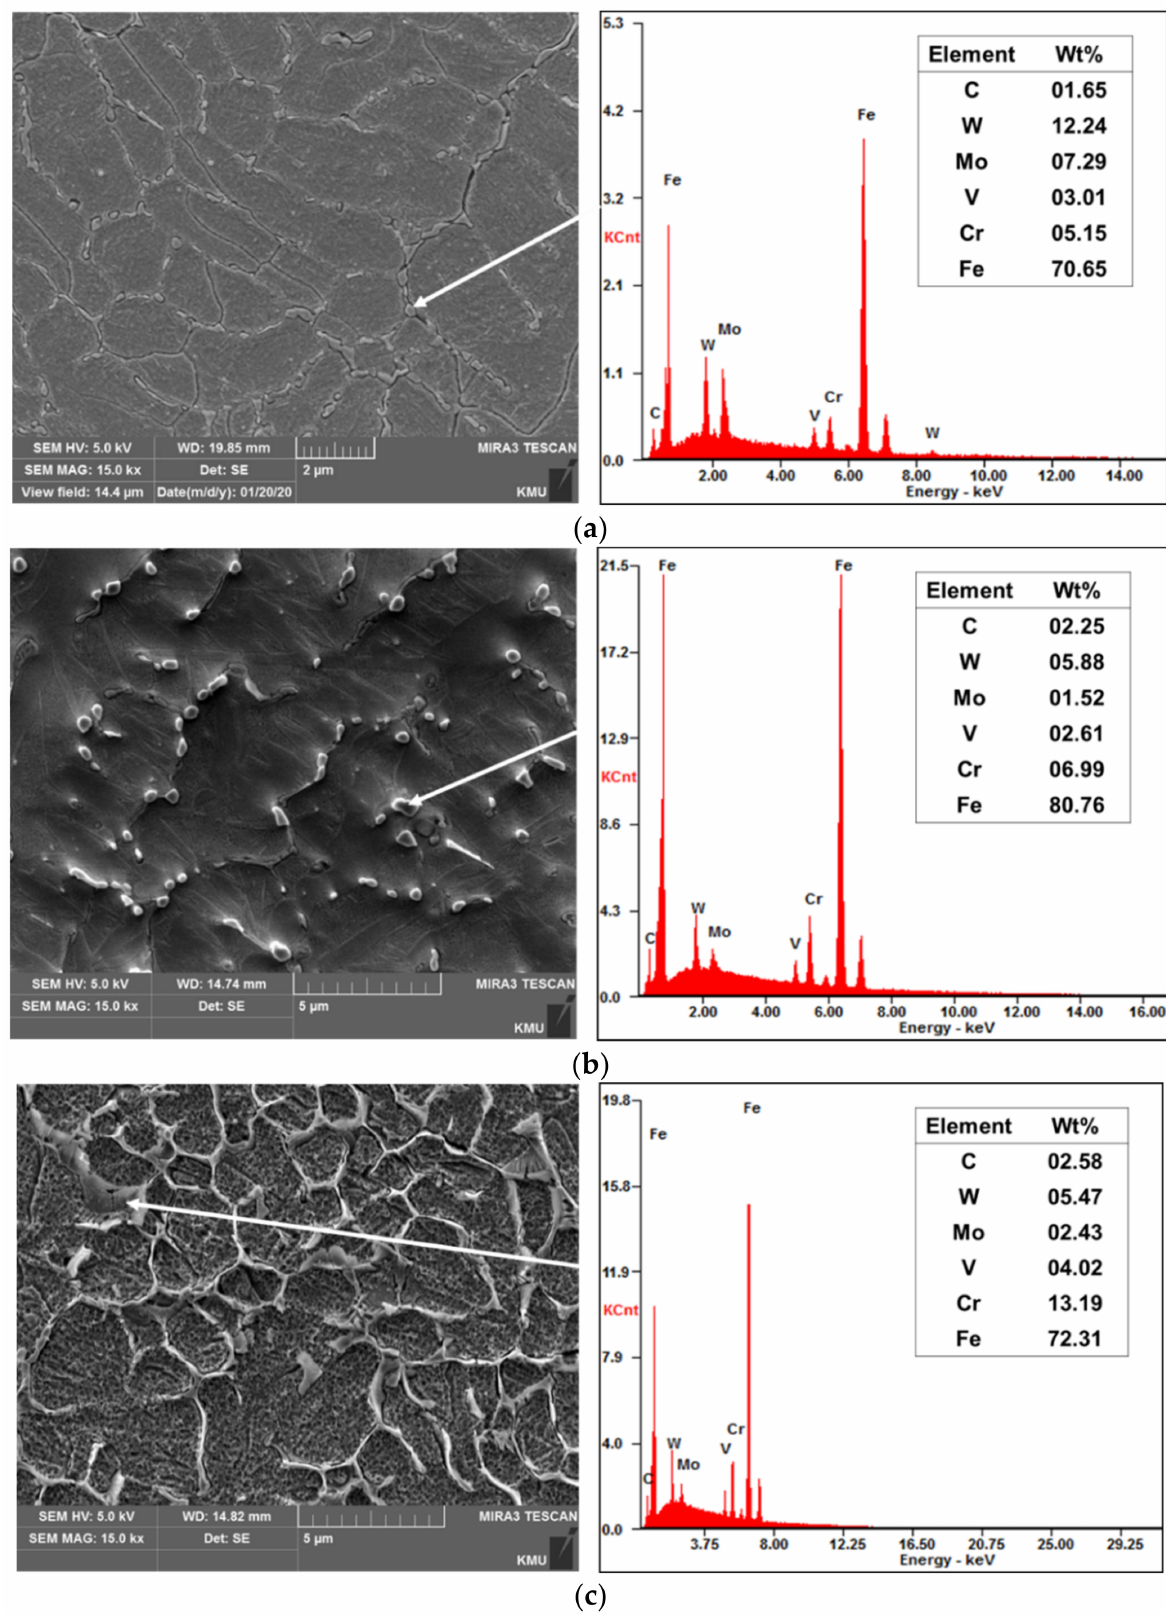
Figure 7. Results of the EDS composition analysis: ( a ) as-built (M2), ( b ) as-built (FeCrVMoW) and ( c ) as-built